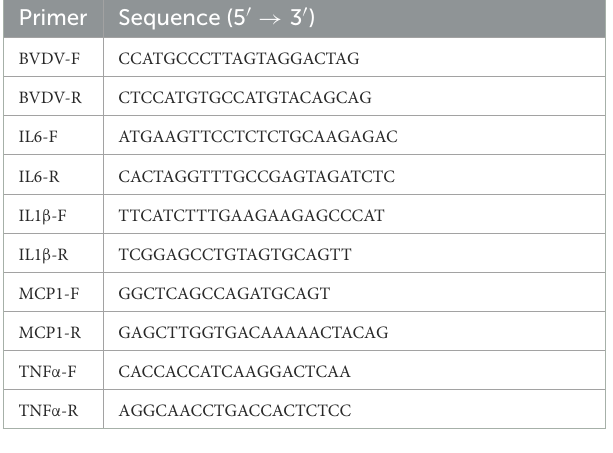
TABLE 2 Disease activity scoring criteria. Score per line item